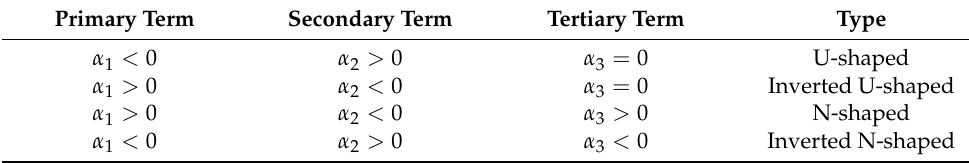
Table 1. The relationship between coefficient values and EKC